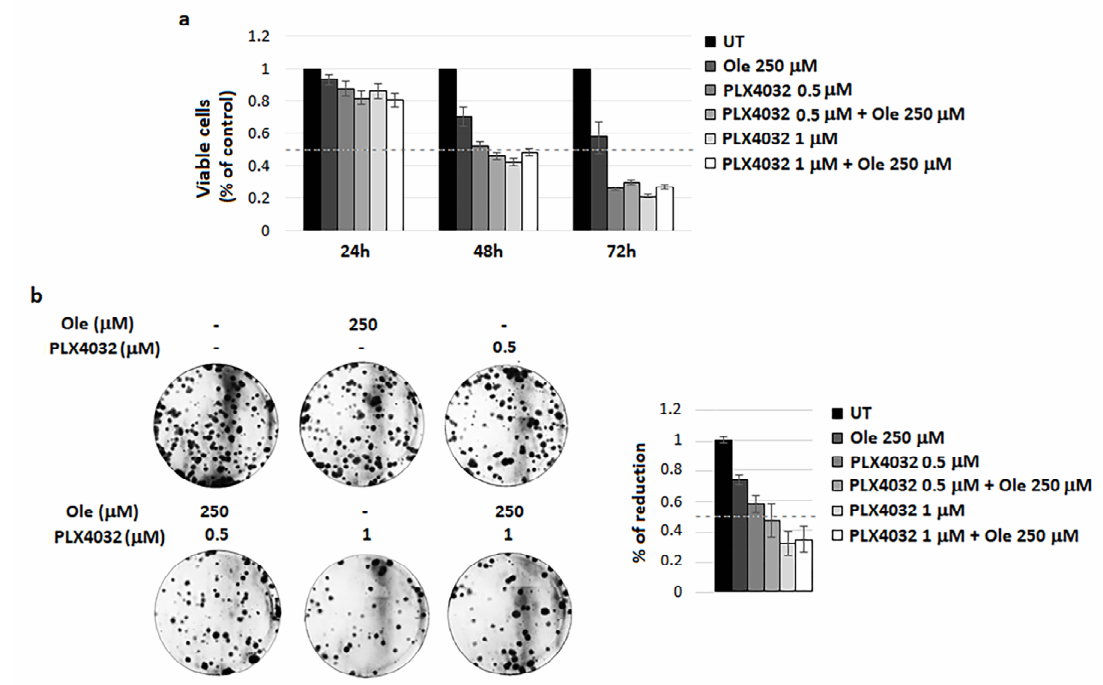
Figure 1. Ole-Vemurafenib (PLX4032) efficacy on A375 melanoma cells. ( a ) Dose–time response evaluated via MTT assay. ( b ) ( Left ) Colony forming units (CFU) assay of alive cells selected using a trypan blue exclusion test after 250 µ M ( ≈ 125 µ g/mL) Ole and/or d treatment for 72 h. ( Right ) Quantification data of the reduction of colony numbers compared to UT. UT =